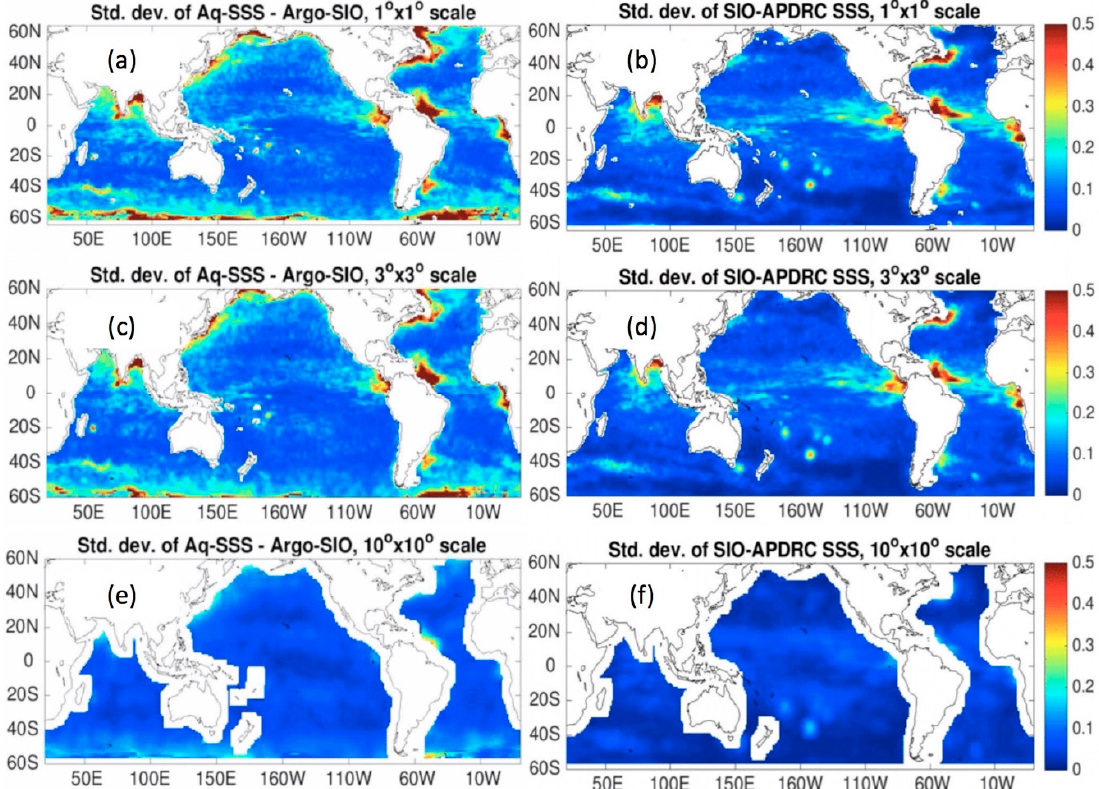
Figure 7. The STD of the difference between Aquarius and Argo-SIO SSS on ( a ) 1° × 1°, ( c ) 3° × 3° and ( e ) 10° × 10° scale. The STD of the difference between Argo-SIO and Argo-APDRC are shown in ( b ), ( d ), and ( f ).